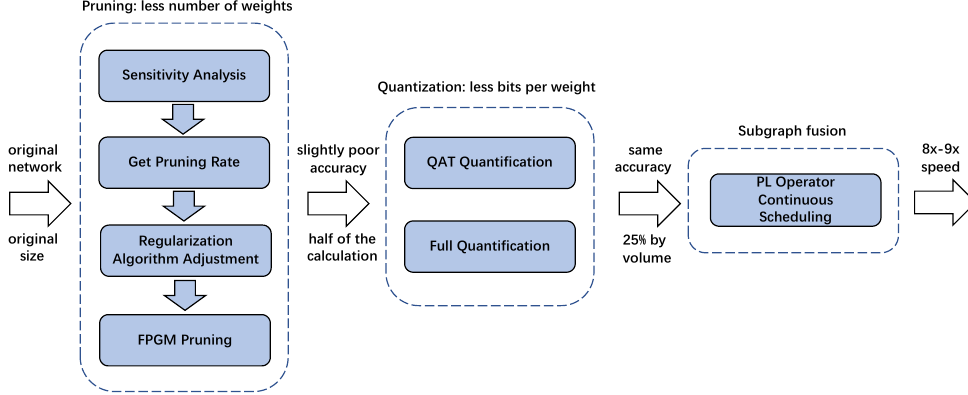
Figure 1. Three-stage accelerated pipeline: pruning, quantization, and subgraph